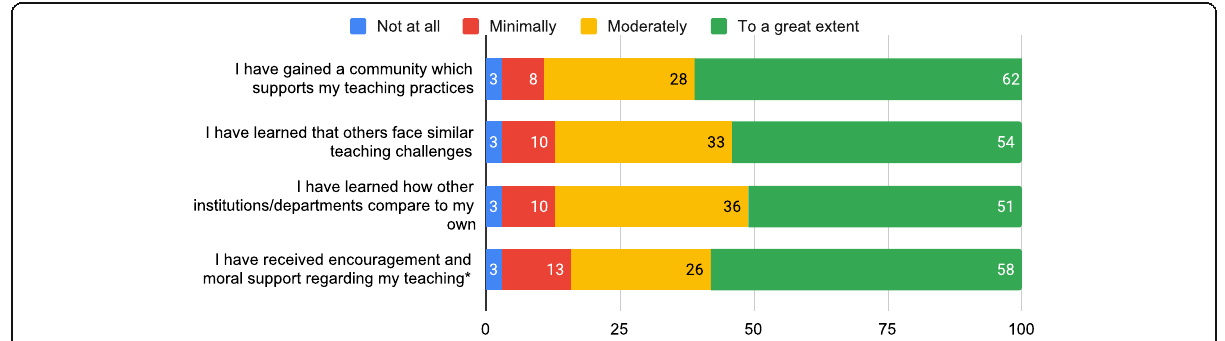
Fig. 2 Community. Percent of respondents reporting benefits to participating in the FOLC in spring 2019 (end of year 2 of the FOLC). Participants rated the extent to which each benefit had occurred as a result of their participation in the FOLC. Items were not presented to participants in this order or identified with the category community . Numbers superimposed on the bars are the percentage of respondents choosing that option. ( N = 39, except for *. N = 38 for *